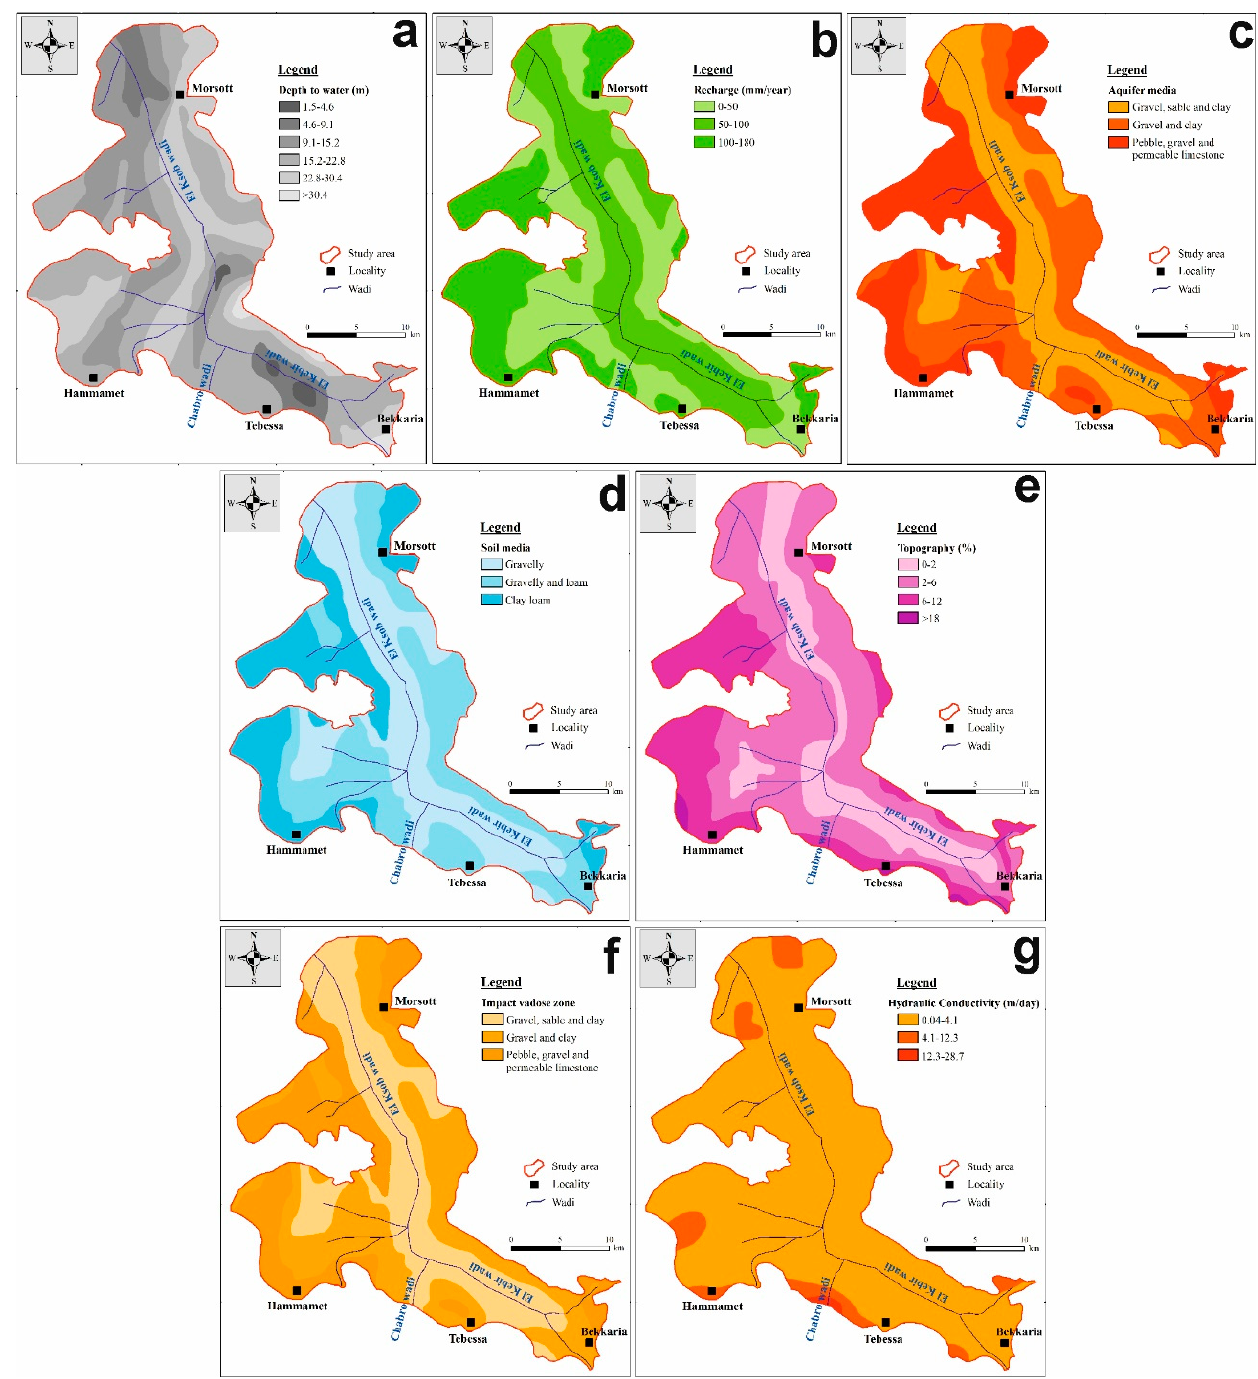
Figure 9. The thematic maps for the DRASTIC model, including depth to water ( a ), net recharge ( b ), aquifer media ( c ) and soil media ( d ), topography ( e ), impact of the vadose zone ( f ) and hydraulic conductivity ( g ).